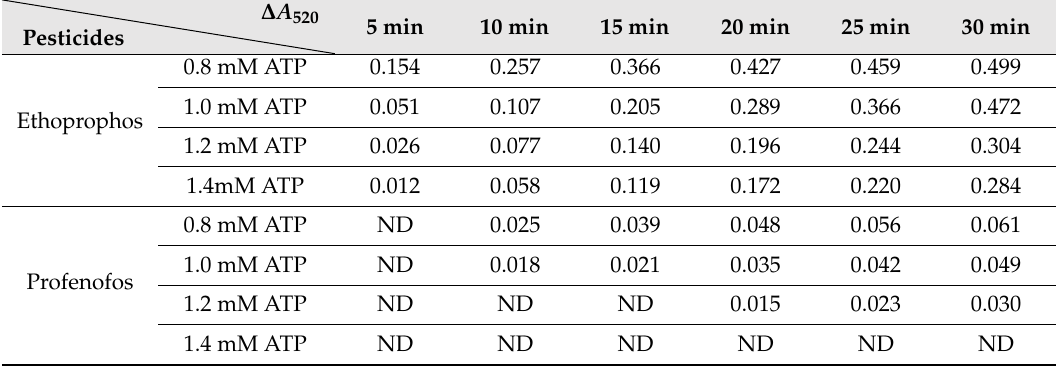
Table 1. The ∆ A 520 of RB-AuNPs with ethoprophos (10.0 µ M) and profenofos (10.0 µ M) in the various concentrations of adenosine triphosphate (ATP).